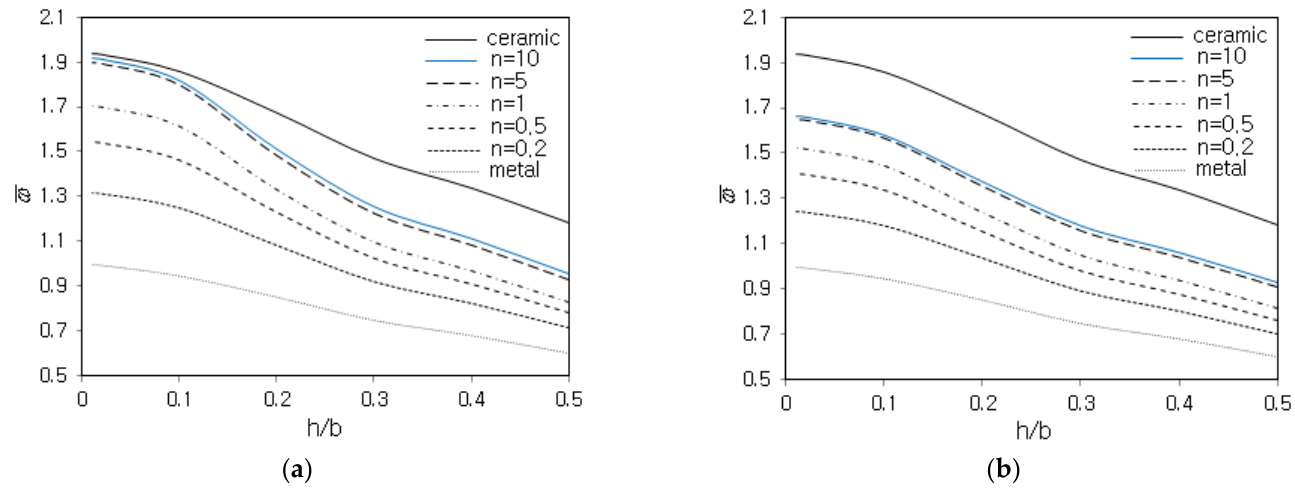
Figure 6. Calibrated fundamental frequencies, ω , for functionally graded sandwich plates with homogeneous softcores: ( a ) (2-2-1), ( b ) (6-6-1). Figure 7a,b represent the curves of FG sandwich plates with homogeneous hard- cores. Because the core was ceramic, the bottom and top curves correspond to and 0 = n , respectively. Contrary to the previous softcore, the fundamental frequency de- with a hardcore became softer with the increasing value of the volume fraction index, n .